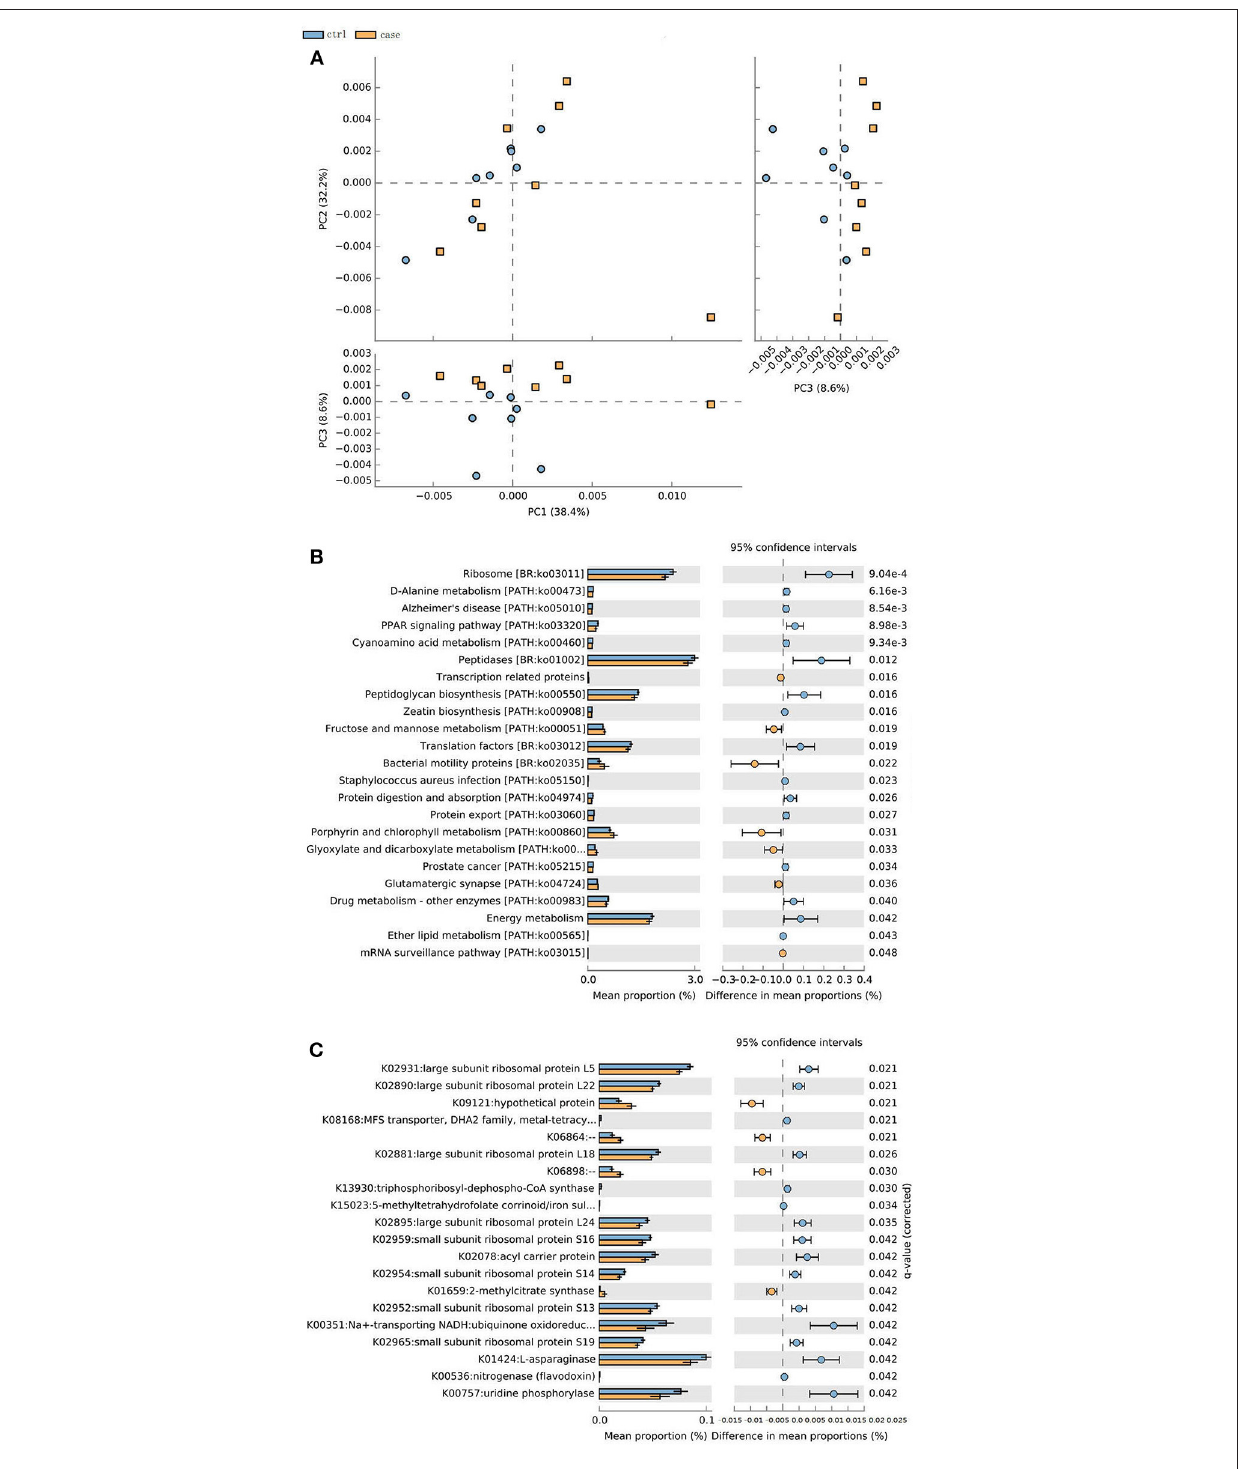
FIGURE 6 | (A) PCoA analysis of all the samples based on gene profiles. The different colors designate samples from different groups, The PCoA demonstrates a separation at the gene level. (B) 20 KOs were significantly different in the ALD and control group. (C) 23 significantly different pathways were enriched in the ALD and control